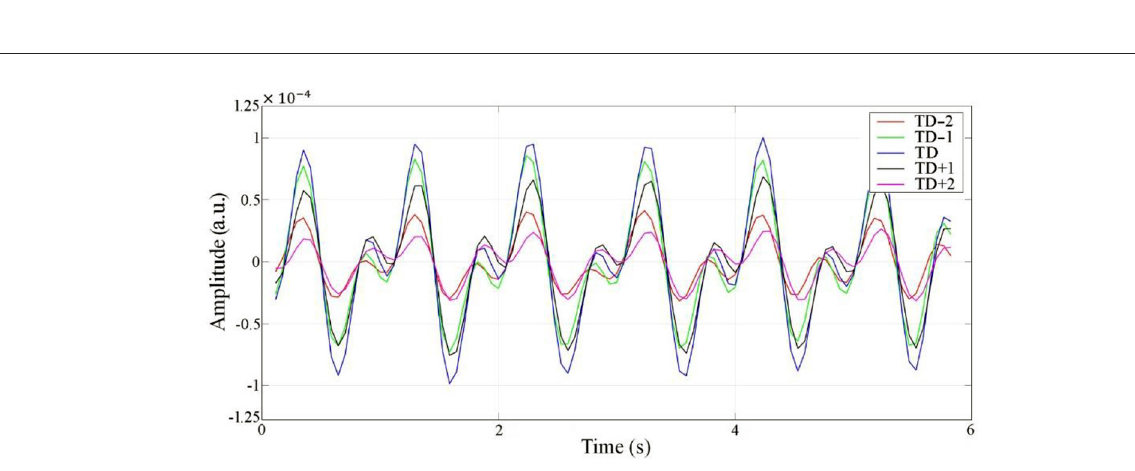
FIGURE8 RCG results from five adjacent range bins.